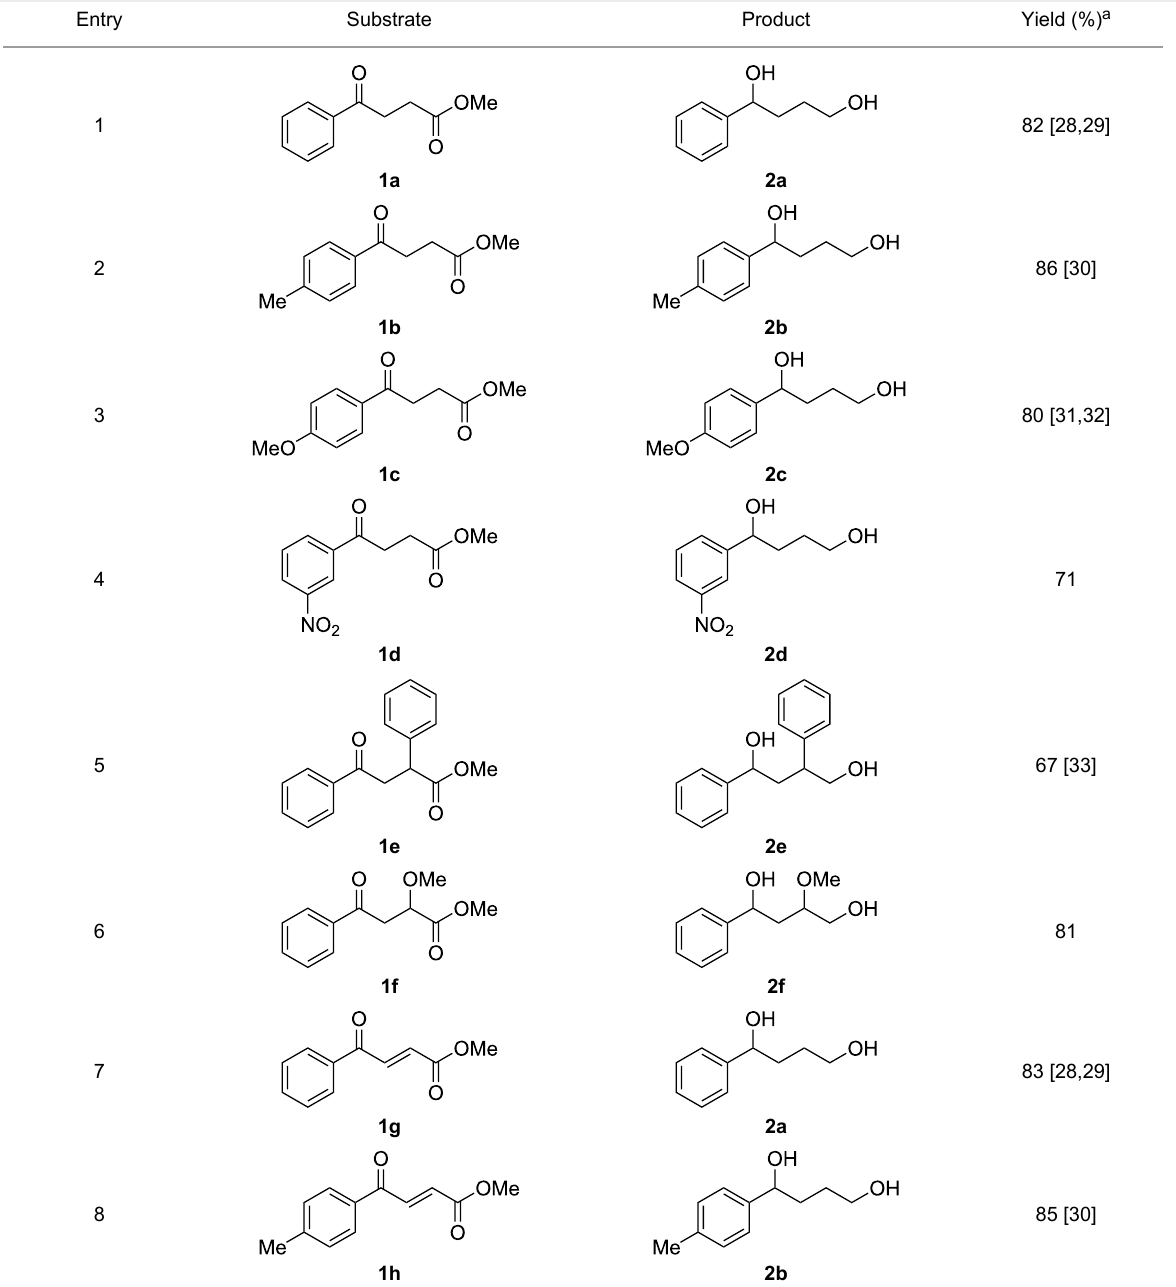
Table 1: Reduction of 4-aryl-4-oxoesters (saturated and α , β -unsaturated) with NaBH 4 in MeOH at room temperature (30